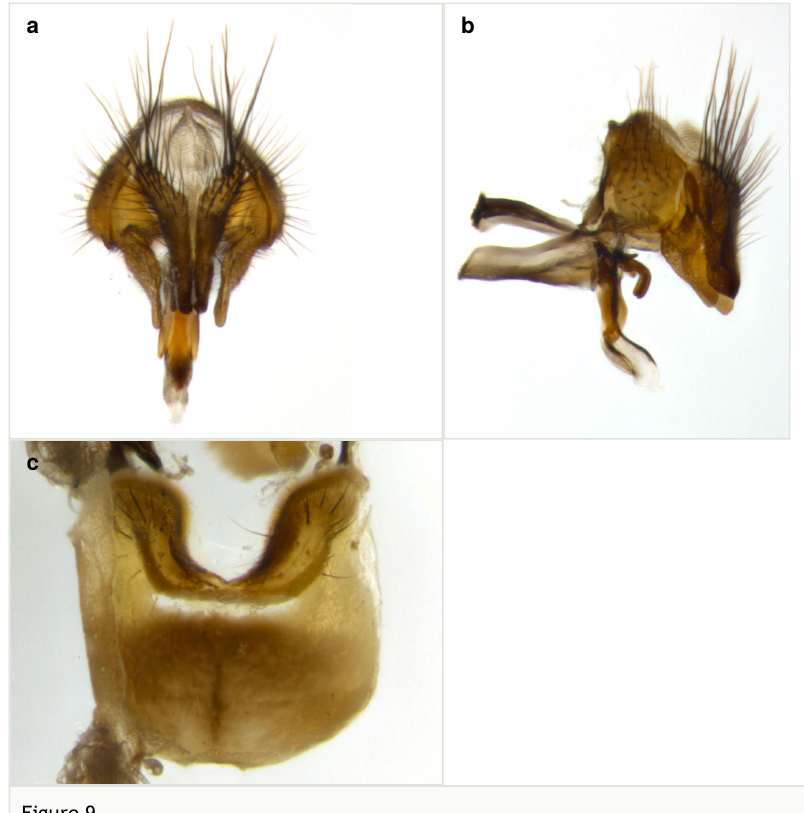
Figure 9. Vibrissina randyjonesi sp. n. Male terminalia, paratype, voucher code: DHJPAR0053319. a : terminalia in dorsal view b : terminalia in lateral view c : sternite 5 in ventral